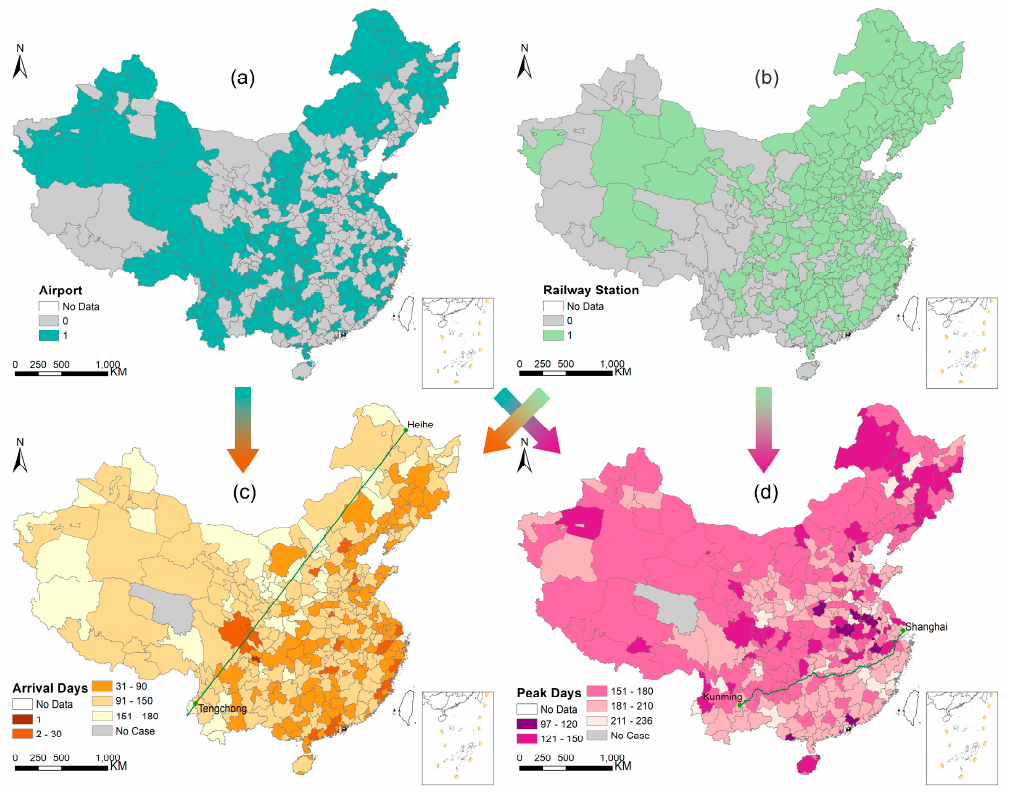
Figure 3. The presence/absence (1/0) of ( a ) airports and ( b ) railway stations in prefectures, and the distributions of ( c ) arrival days and ( d ) peak days for prefectures. The green line in ( c ) indicates the Heihe-Tengchong (Hu) line, and the one in ( d ) indicates the Hukun Railway that connects Shanghai and Kunming. The arrows illustrate that arrival days (or peak days) between prefectures with and without airports (or railway stations) are compared using the Mann-Whitney U test, and their spatial heterogeneity stratified by airports (or railway stations) are detected using q -statistic test.